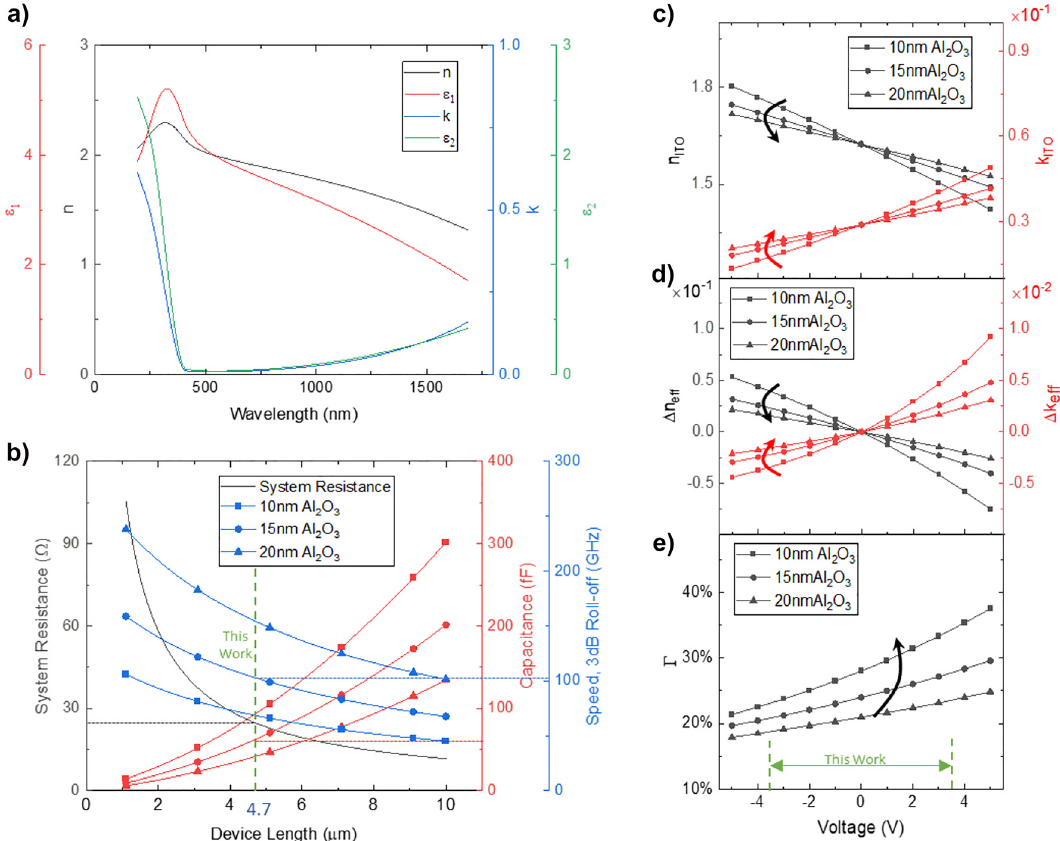
Figure 2: Tailored material and design parameters of the phase shifter. (a) Dispersive spectrum of 10 nm ITO thin fi lm measured by ellipsometry. (b) Resistance and speed of ITO MZI modulator with a gating oxide thickness of 10 nm, 15 nm, and 20 nm. (c) Refractive indices and extinction coef fi cients of 10 nm in thick and 4.7 µm in length ITO thin fi lm for various dielectric thicknesses under different voltages at 1550nm.(d)Effectivemodeindexdifferenceschangewithdielectricthicknessundervariedvoltagesat1550nm.(e)Con fi nementfactor Γ varies with dielectric thickness and voltages at 1550